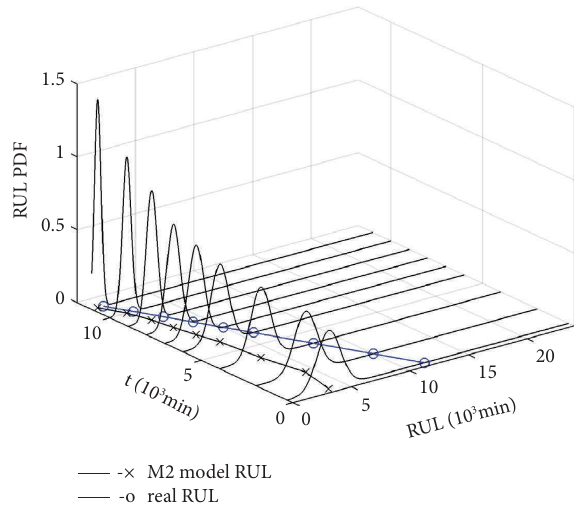
Figure 7: RUL estimation of the M2 model in a1 sample.